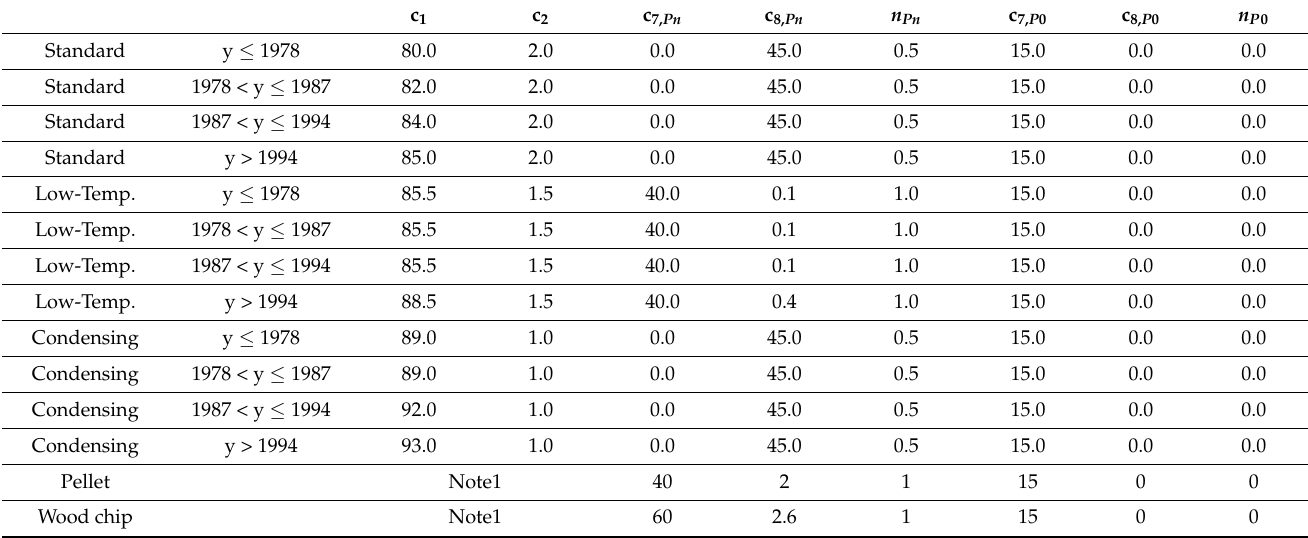
Table A6. Coefficients for the calculation of default values for gas water heaters.